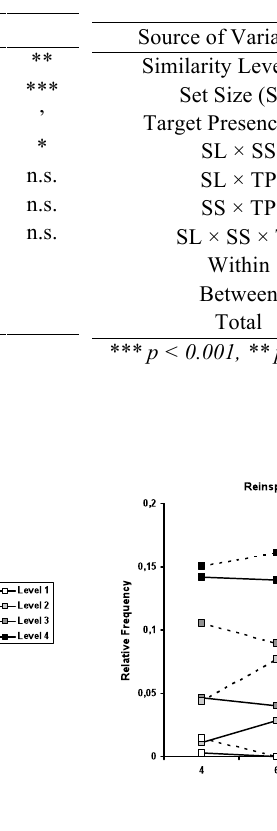
Three-way repeated measures analysis of variance for fixation duration.